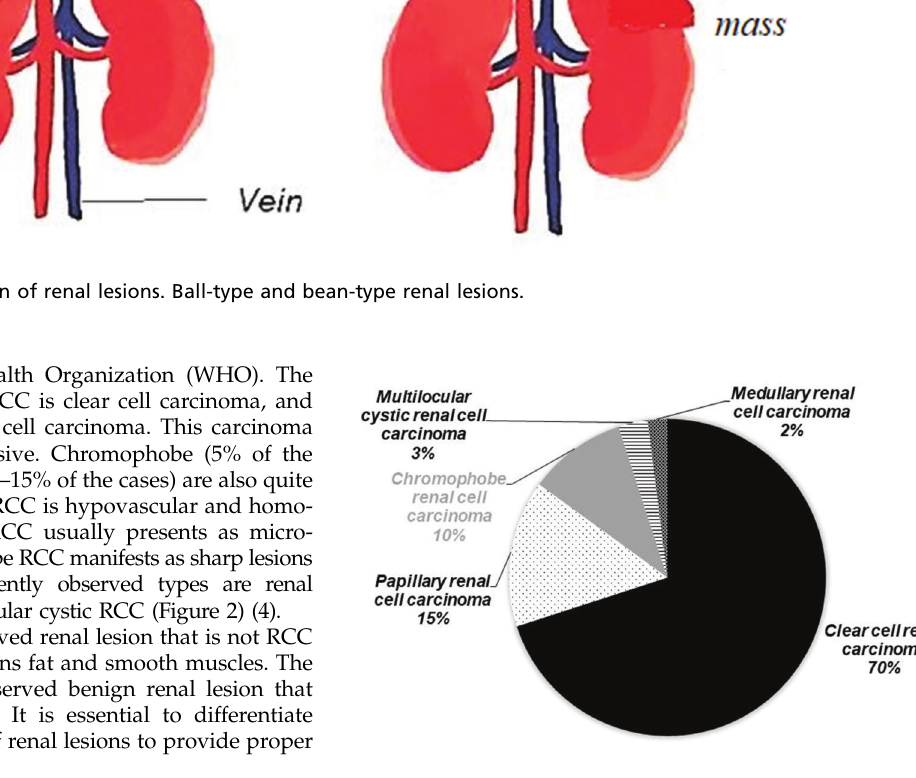
Figure 2 - Frequency of occurrence of different types of renal cell carcinoma in the